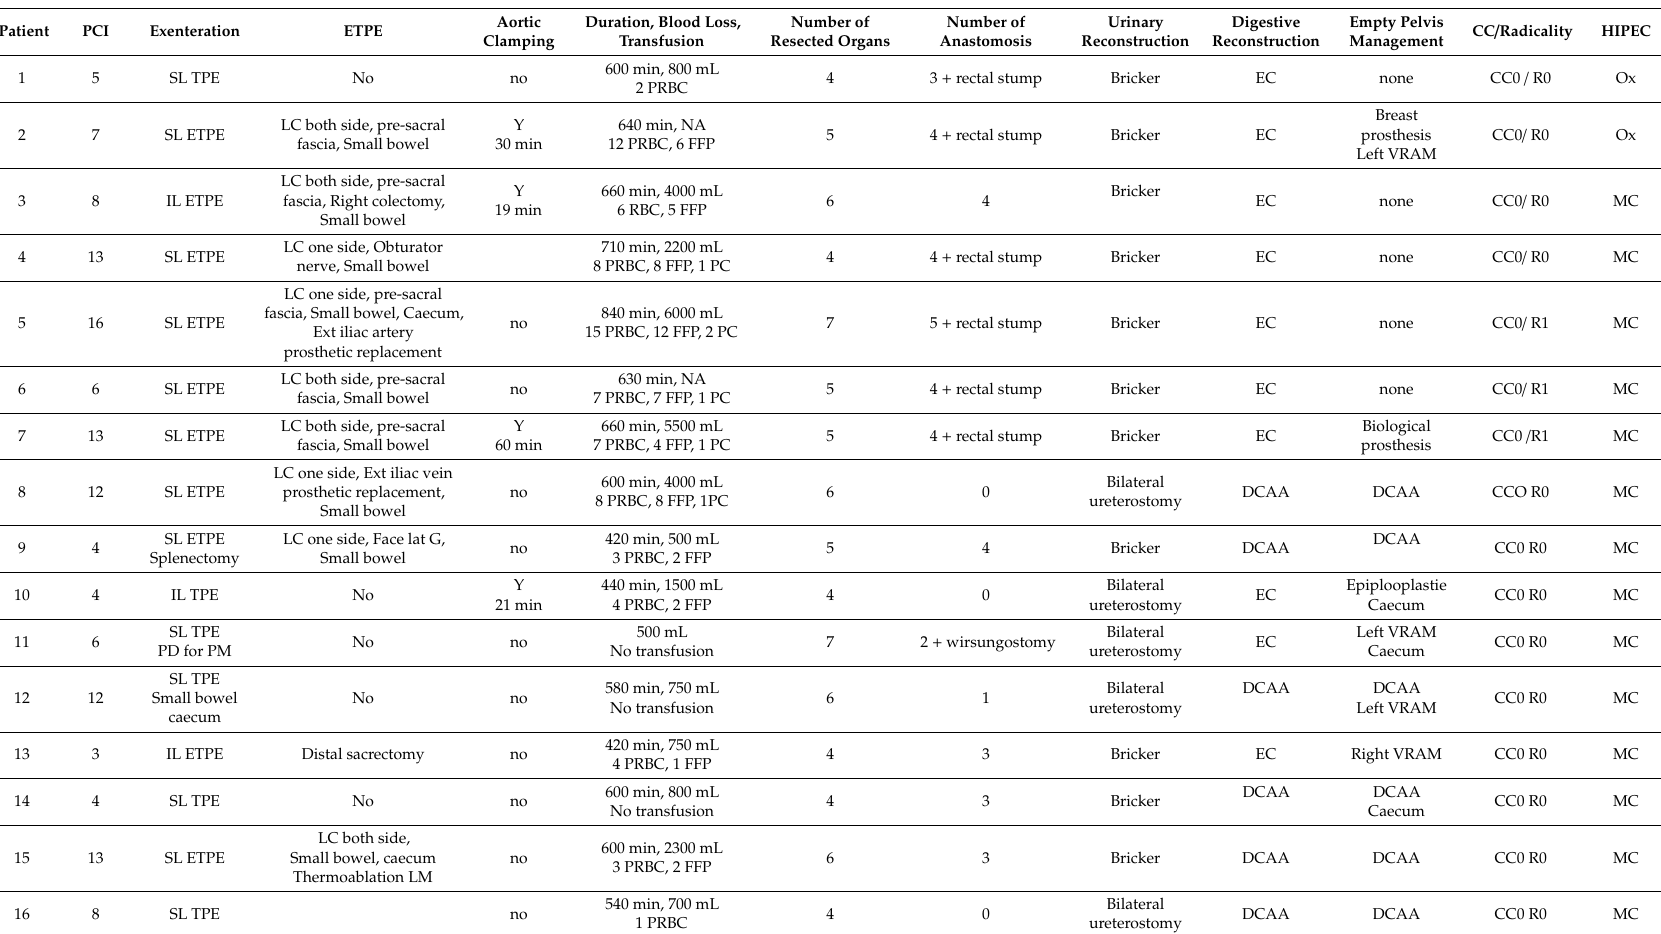
Table 2. Detailed information on the surgical